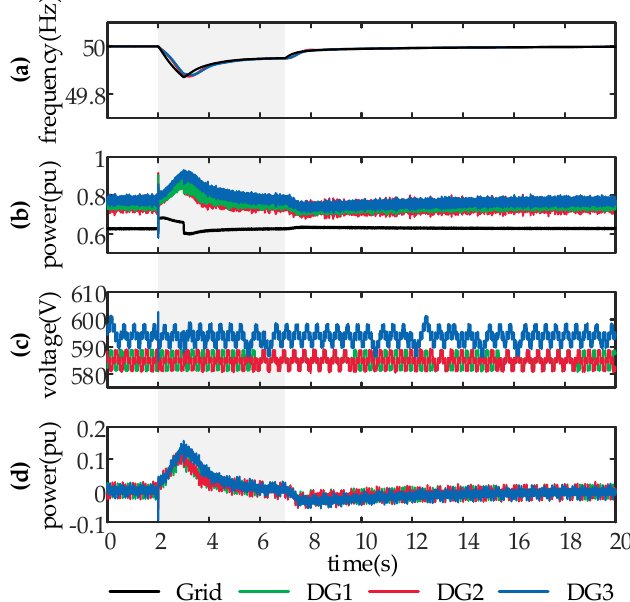
Figure 11. Responses to a short circuit fault when the proposed PV systems are applied as DG1–DG3: ( a ) Frequency response; ( b ) output active power; ( c ) dc link voltage of the inverter; ( d ) exchanged power between the ES unit and dc link.